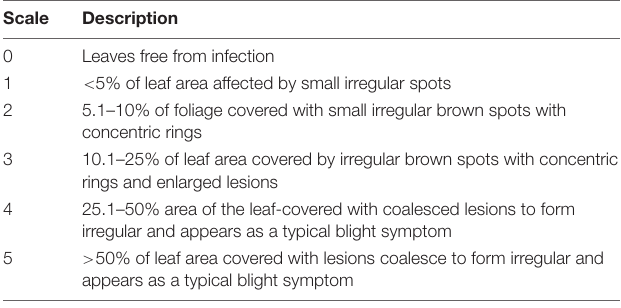
TABLE 3 | The disease rating scale for tomato early blight (Pandey et al., 2003).